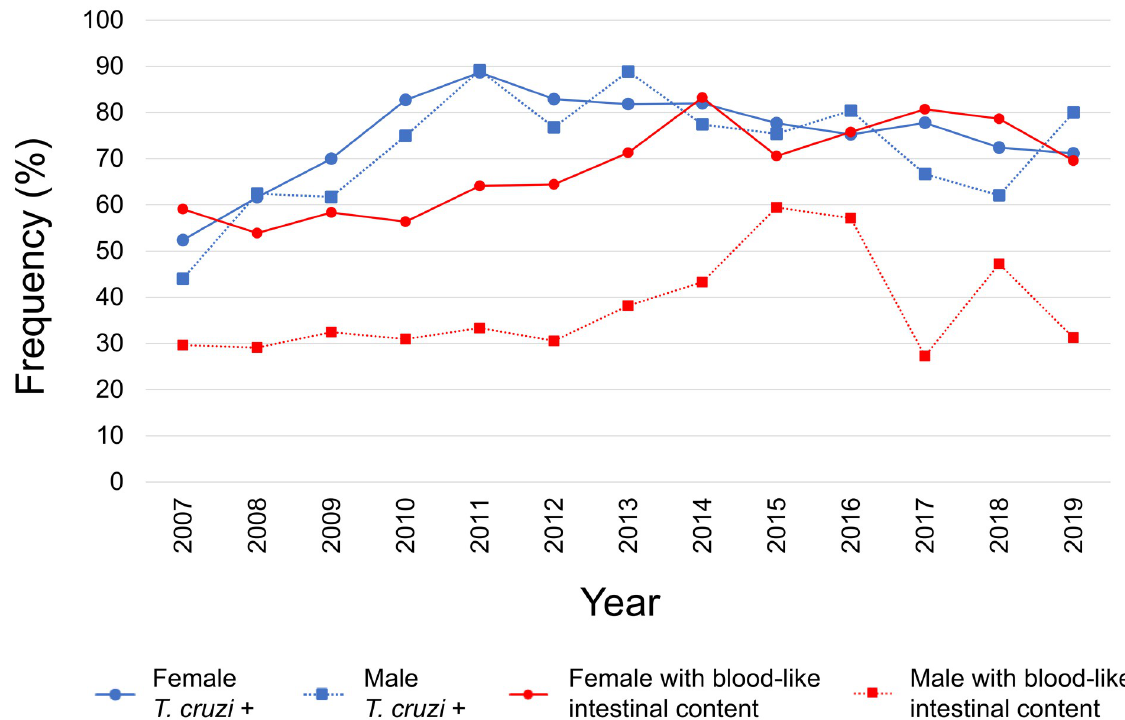
Fig 3. Annual rates of natural T . cruzi infection and observations of blood-like intestinal content in male and female triatomine specimens for the MDC collection period 2007–2019. Blue color indicates the rate of T . cruzi infection among 3845 specimens analyzed. Red color indicates the rate at which blood-like intestinal content was observed among 4422 specimens analyzed. Circles and squares indicate values for females and males, respectively.